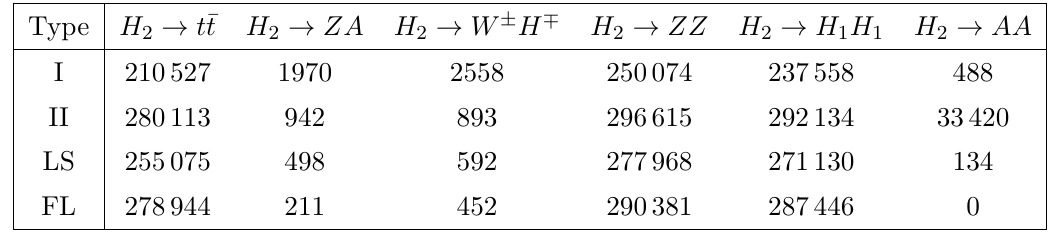
Table 18 . Number of parameter points available for the analysis in the individual OS decay channels of the non-SM-like Higgs boson H 2 ( H 1 is